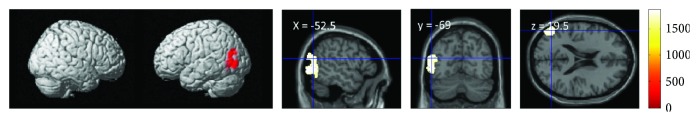
The effect of training with TCSSL on rGMV. The results shown were obtained using a threshold of threshold-free cluster enhancement (TFCE), P < 0.05 based on 5000 permutations. There was a greater decrease in rGMV in the training with TCSSL group compared with the active control group (this analysis was performed to identify differences in pre- to posttraining changes between groups, as described in the Methods section). Compared with the active control training, the training with TCSSL resulted in a decrease in rGMV in the junction of the left middle and STG and the left middle and superior occipital gyri.